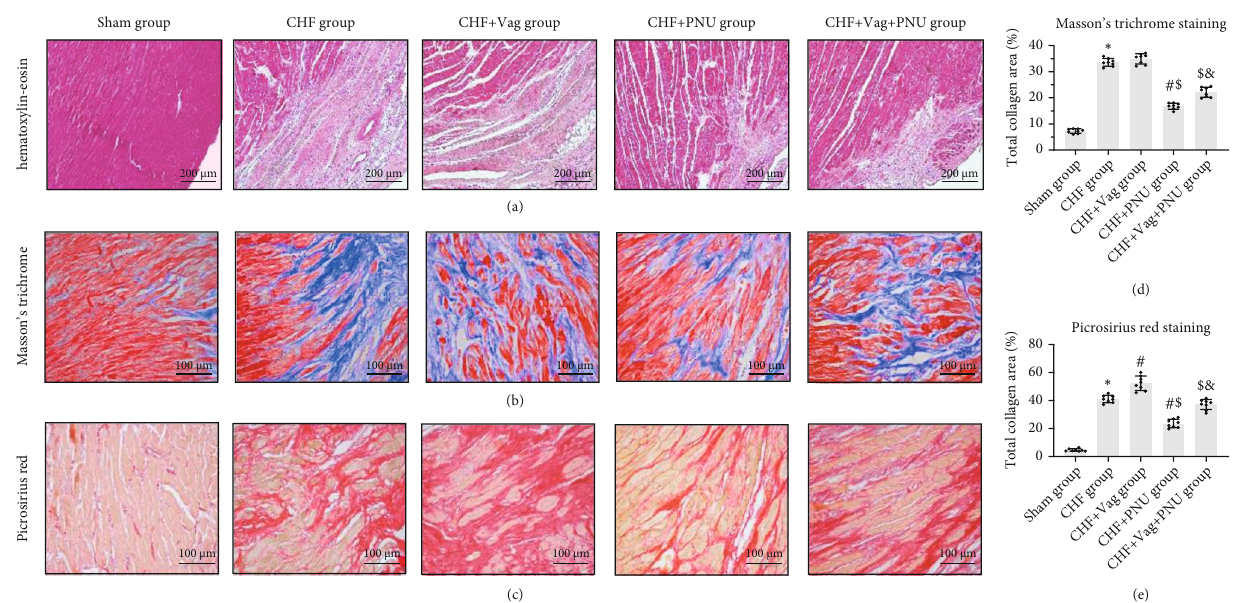
Figure 4: E ff ects of cholinergic elicitation on cardiac fi brosis. Representative images of scar ranges by HE staining in fi ve groups (a) ( × 10). Masson ’ s trichrome staining and picrosirius red staining of left ventricular noninfarct sections in fi ve groups (b, c) ( × 20). Quantitative statistics of collagen contents (d, e). ∗ P < 0 : 05 vs. Sham group. # P < 0 : 05 vs. CHF group. $ P < 0 : 05 vs. CHF+Vag group. & P < 0 : 05 vs. CHF+PNU